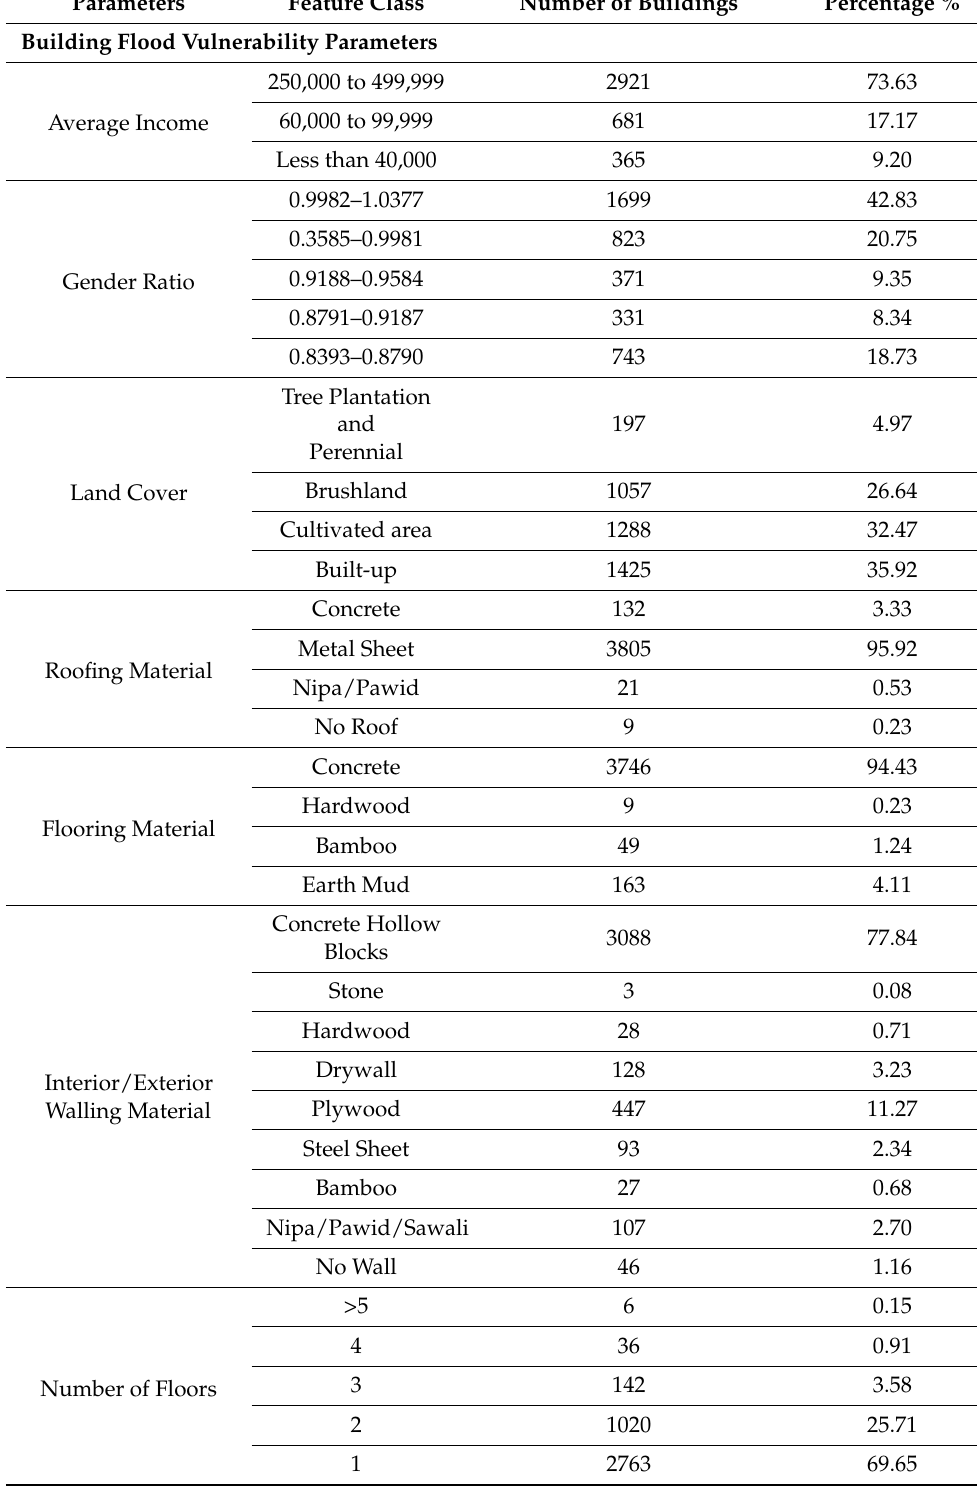
Table A2. Feature count of the building flood vulnerability